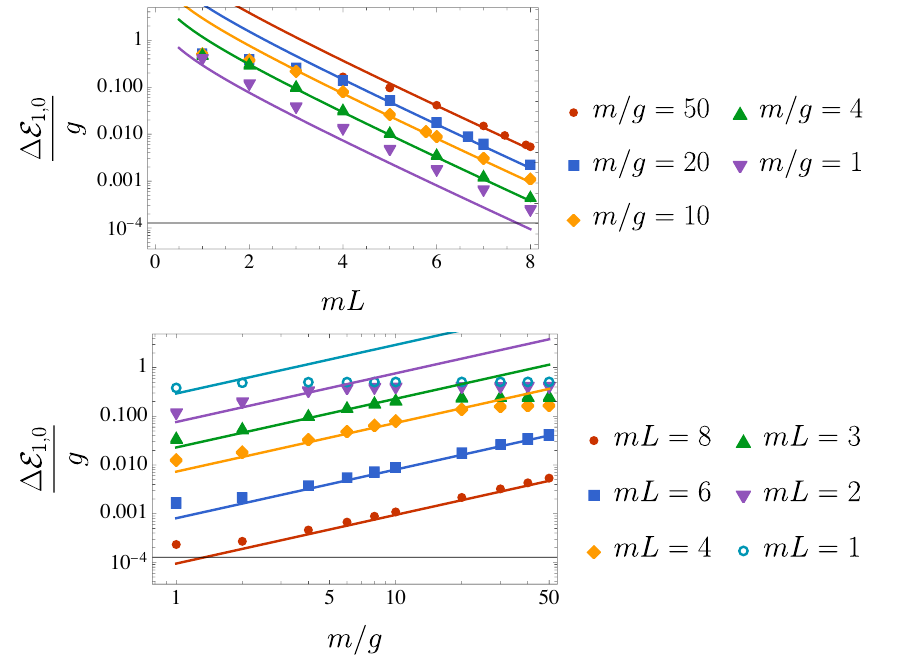
√ x fixed, N → ∞ ) lattice results (dots) versus the between the ground 1 , 0 /g